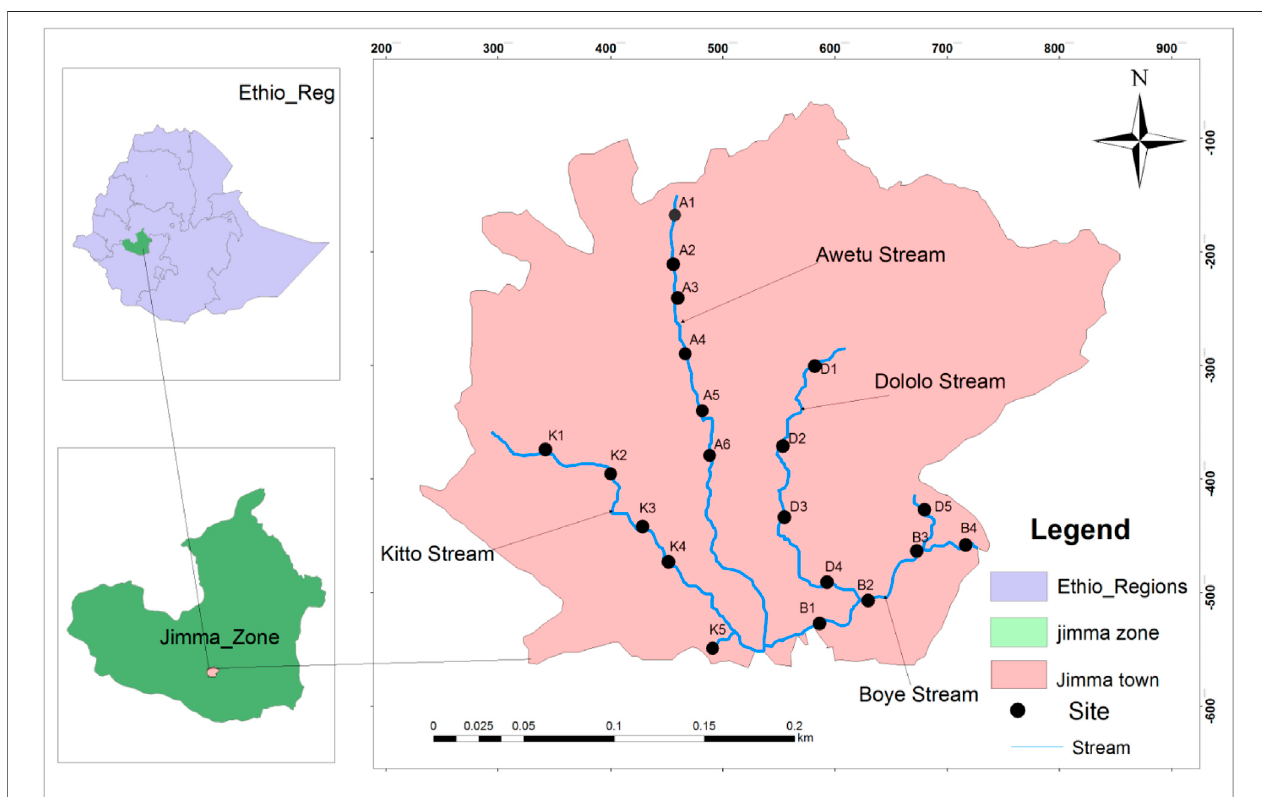
FIGURE 1 | Map showing the study area and location of sampling sites in the streams of Awetu watershed.